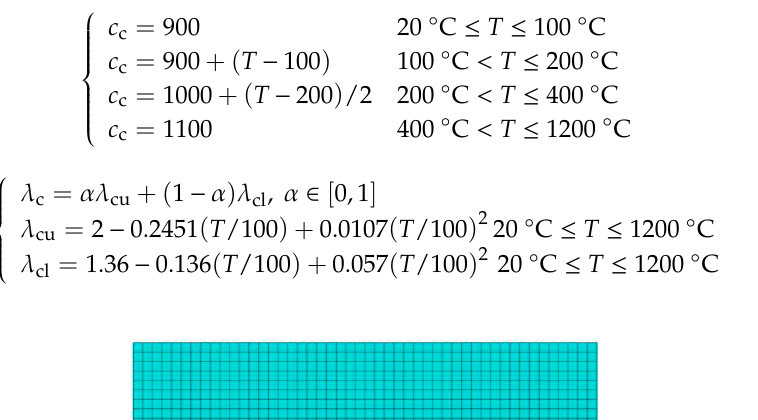
Figure 8. Cracks of specimen. (a) Cracks on the soffit; (b) cracks on the front and back surfaces.